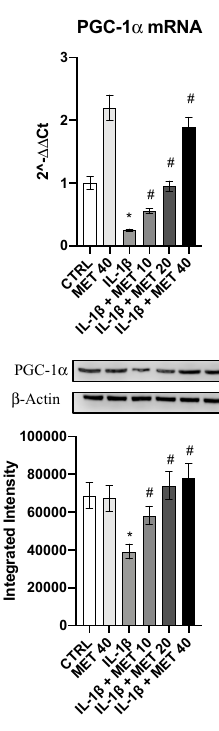
Figure 5. Effects of metaxalone on cell viability at 24 h ( A ), 48 h ( B ), and 72 h ( C ). Values are expressed as the means ± SD. *, p < 0.0001 vs. CTRL.